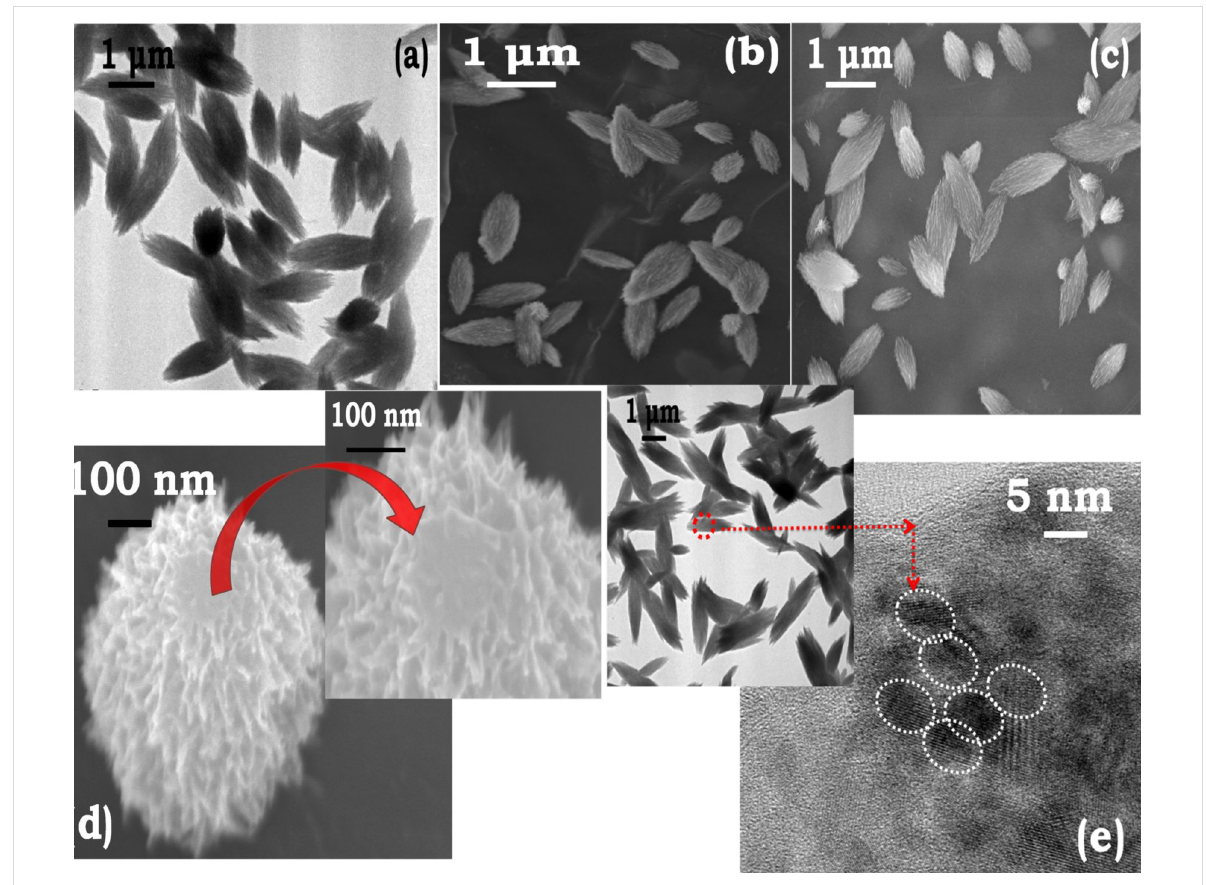
Figure 9: Cobalt structures formed in the presence of NH 4 OH. (a,b) FEGTEM and FEGSEM micrographs captured after 15 min of ageing show spin- dles with length l = 900 nm and diameter d = 200 nm; (c) FEGSEM micrograph captured after 45 min of ageing shows spindles with length l = 1100 nm and diameter d = 230 nm; (d) FEGSEM micrograph of a single spindle standing on its tip; the figure shows irregular corrugations on the surface of the spindle; (e) high-resolution FEGTEM micrograph of a spindle.